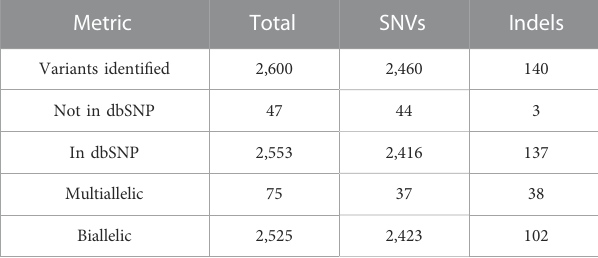
TABLE 2 Variant calling statistics for the panel of 69 genes involved in lipid